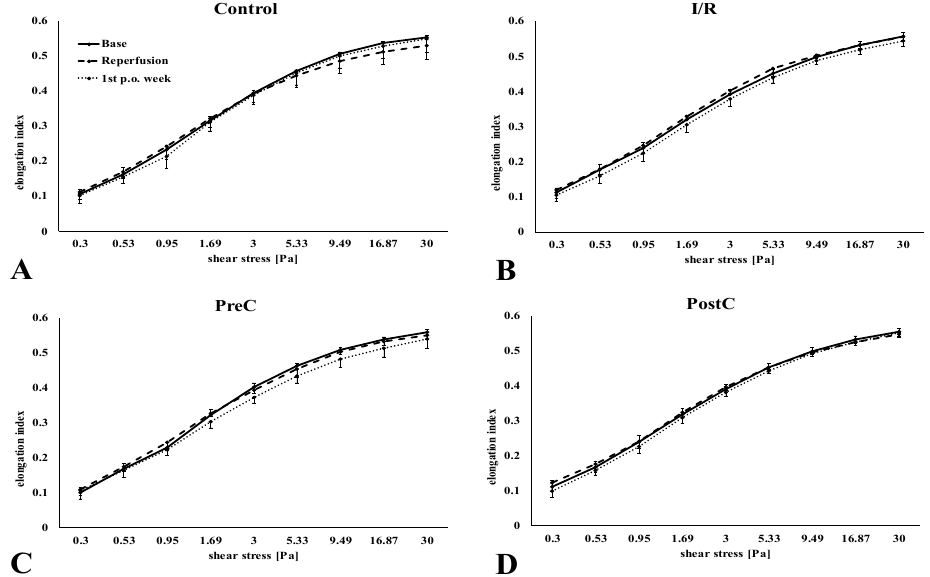
Figure 1. Changes of red blood cell deformability (elongation index in the function of shear stress in the control ( A ), the ischemia-reperfusion (I/R) ( B ), the ischemic pre-conditioning (PreC) ( C ) and the ischemic post-conditioning (PostC) ( D ) groups. Means ± S.D. Table 2. Erythrocyte deformability values delivered from the elongation index (EI): shear stress (SS) curves in the control, the ischemia-reperfusion (I/R), the ischemic pre-conditioning (PreC), and the ischemic post-conditioning (PostC) groups.